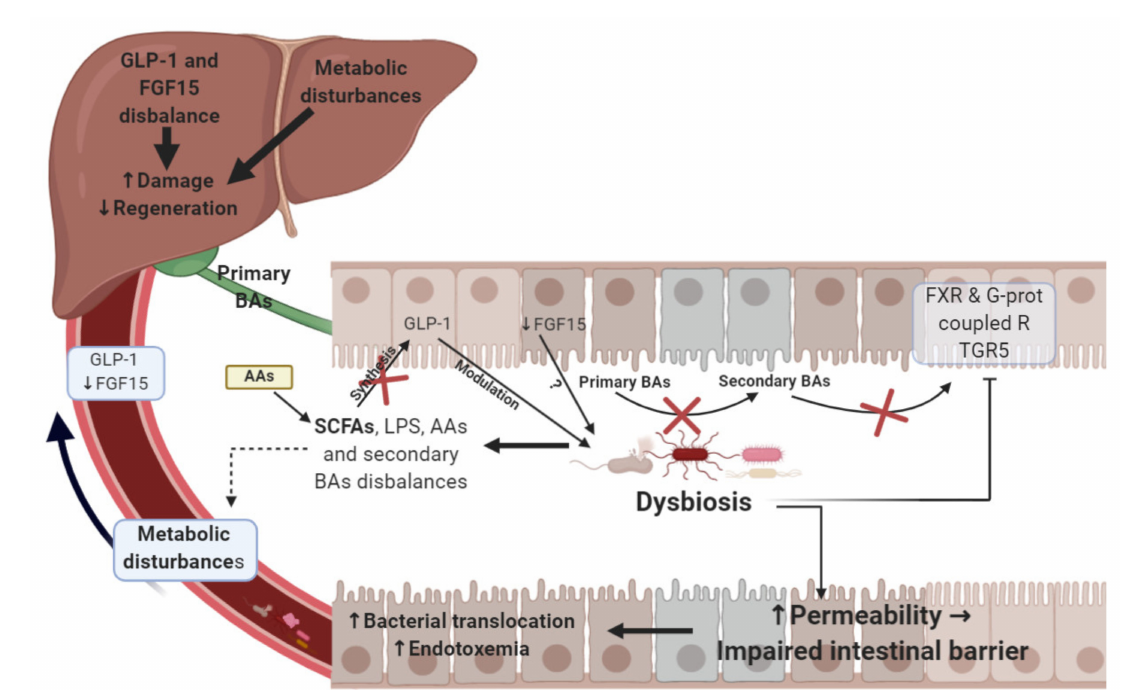
Figure 1. Association between gut microbiota and liver function in liver surgery. Gut dysbiosis leads to an imbalance in microbial metabolites such as SCFAs, LPS or secondary BAs, thus provoking metabolic disturbances and affecting GLP-1 and FGF15 synthesis or FXR and G-protein coupled receptor TGR5 signaling. All of this may increase liver damage and decrease liver regeneration ability. Dysbiosis also seems to alter gut permeability, inducing damaging effects on the intestinal barrier and causing bacterial translocation and endotoxemia. Gut bacteria also provide amino acids to the host and can alter their bioavailability. In addition, amino acids act as precursors for the synthesis of metabolic end products produced by the microbiota such as SCFAs. ↑ : Increase; ↓ : Decrease; AAs: Amino acids; BAs: Bile acids; FXR: Farnesoid X receptor; FGF15: Fibroblast growth factor 15; GLP-1: Glucagon-like peptide 1; LPS: Lipopolysaccharides; R TGR5: Receptor of Takeda G protein-coupled receptor 5; SCFAs: Short-chain fatty